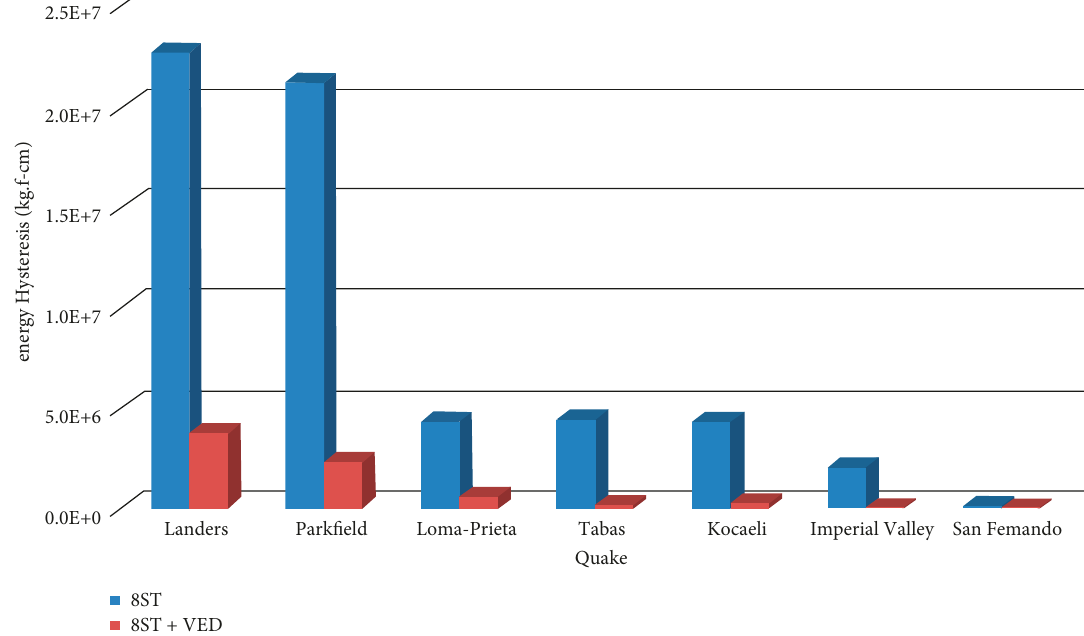
Figure 10: Hysteresis energy applied to the 8 8 floor frame under near-field records, in both modes with and without dampers.